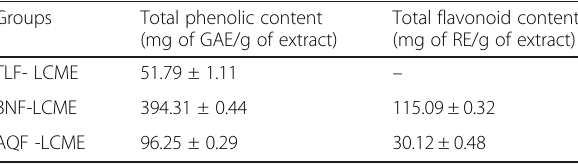
Table 1 The total phenolic and flavonoid contents of the fractions of